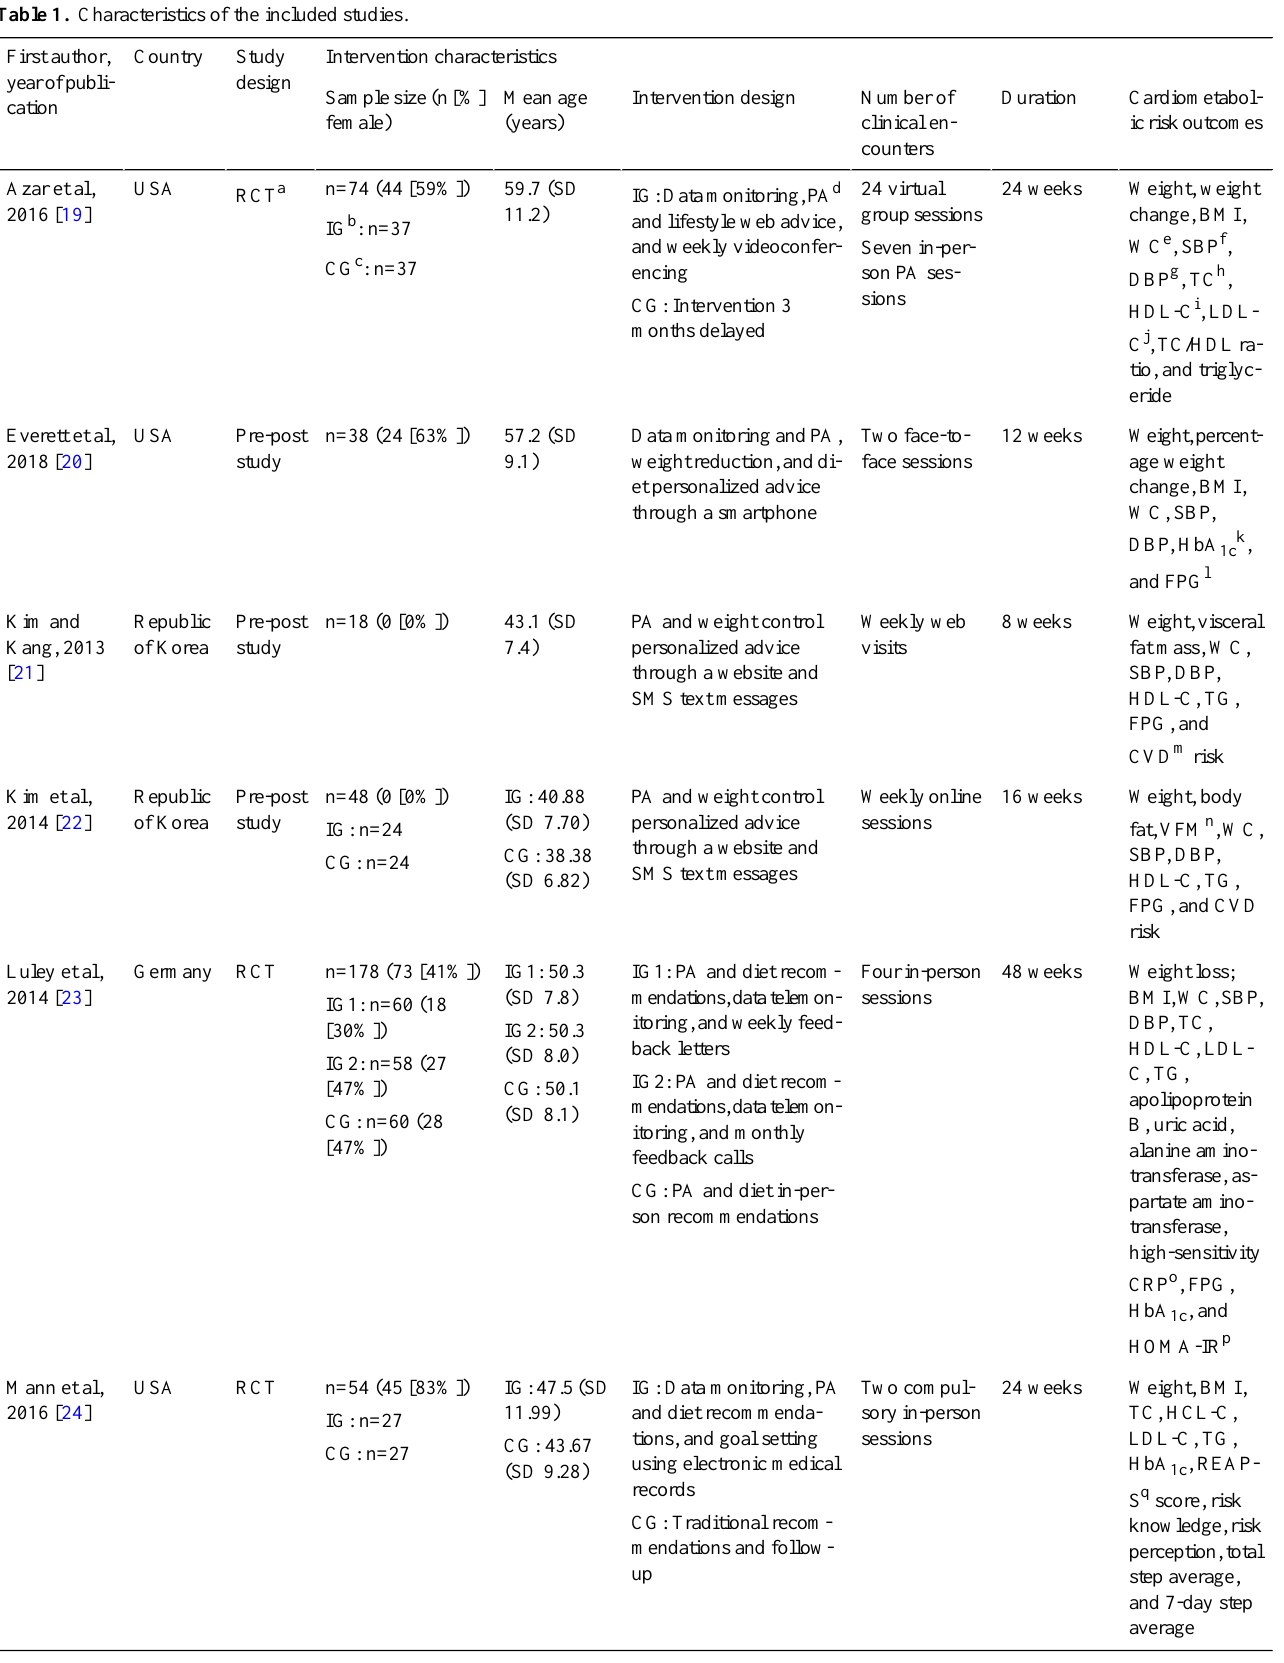
Table 1. Characteristics of the included studies. Intervention characteristicsStudy designCountryFirst author, year of publi- cation